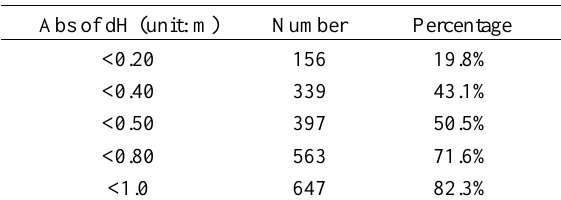
Table 2. Statistical results for the deviation between GLAS and LIDAR average